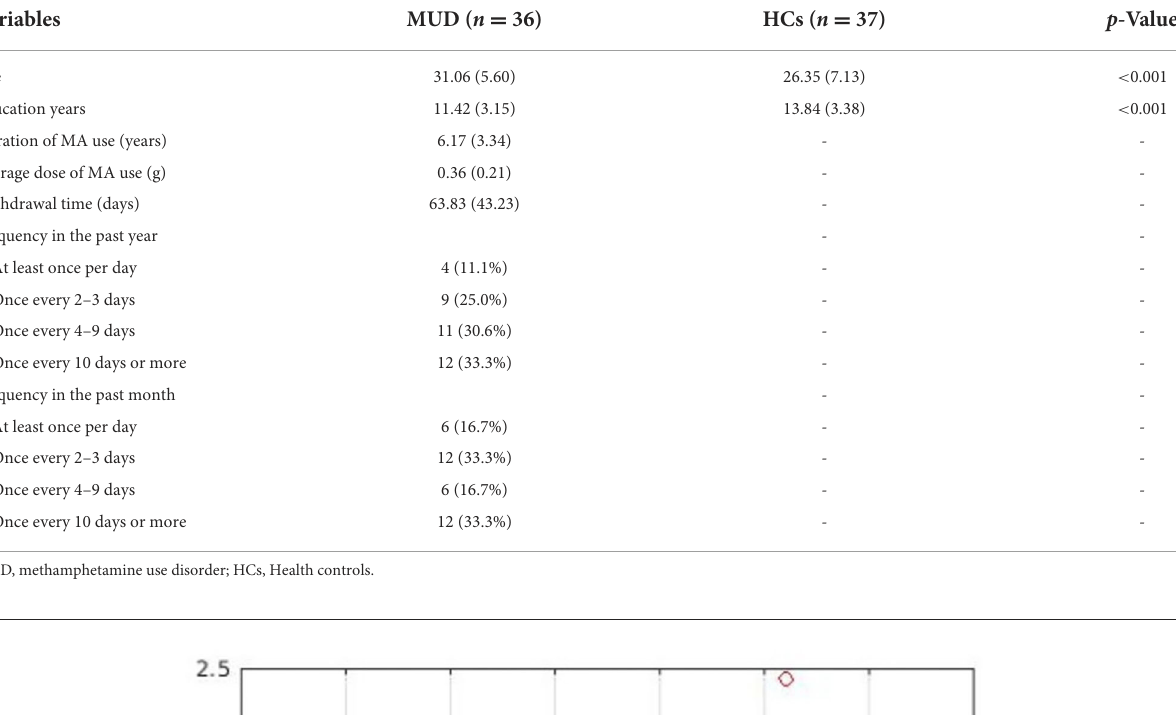
TABLE 1 Participant demographics and clinical characteristics.